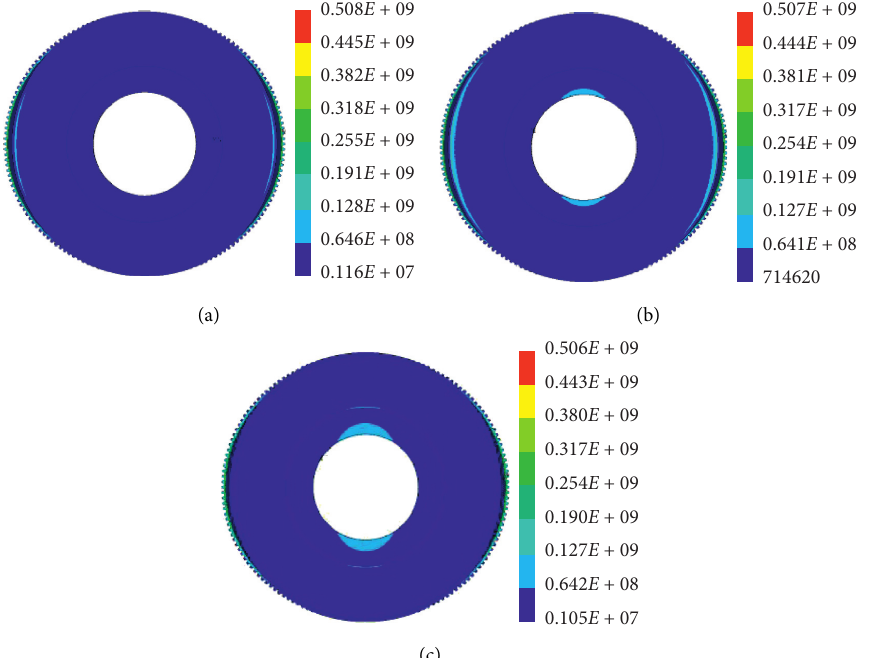
Figure 13: Flexspline stress cloud chart of different bottom wall thicknesses. (a) δ ″ � 0.80mm. (b) δ ″ � 0.95mm. (c) δ ″ � 1.15mm.